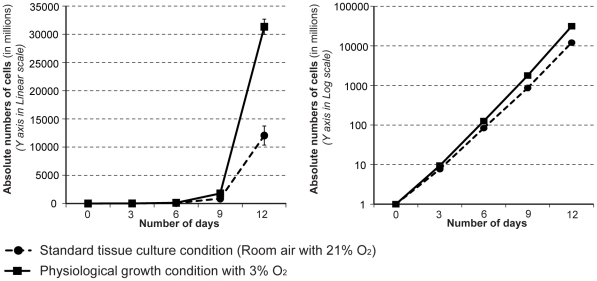
Cancer cell proliferation is markedly suppressed by the standard cell culture conditions used for in vitro experiments.Equal numbers of A2780 ovarian cancer cells were seeded in a 10 cm petri dish and were routinely maintained under 3% O2 (physiological) or 21% O2 (ambient). The increase in cell numbers was determined by counting manually once in three days, and the total cell numbers were estimated and plotted using linear scale (in Graph A) and log scale (in Graph B).